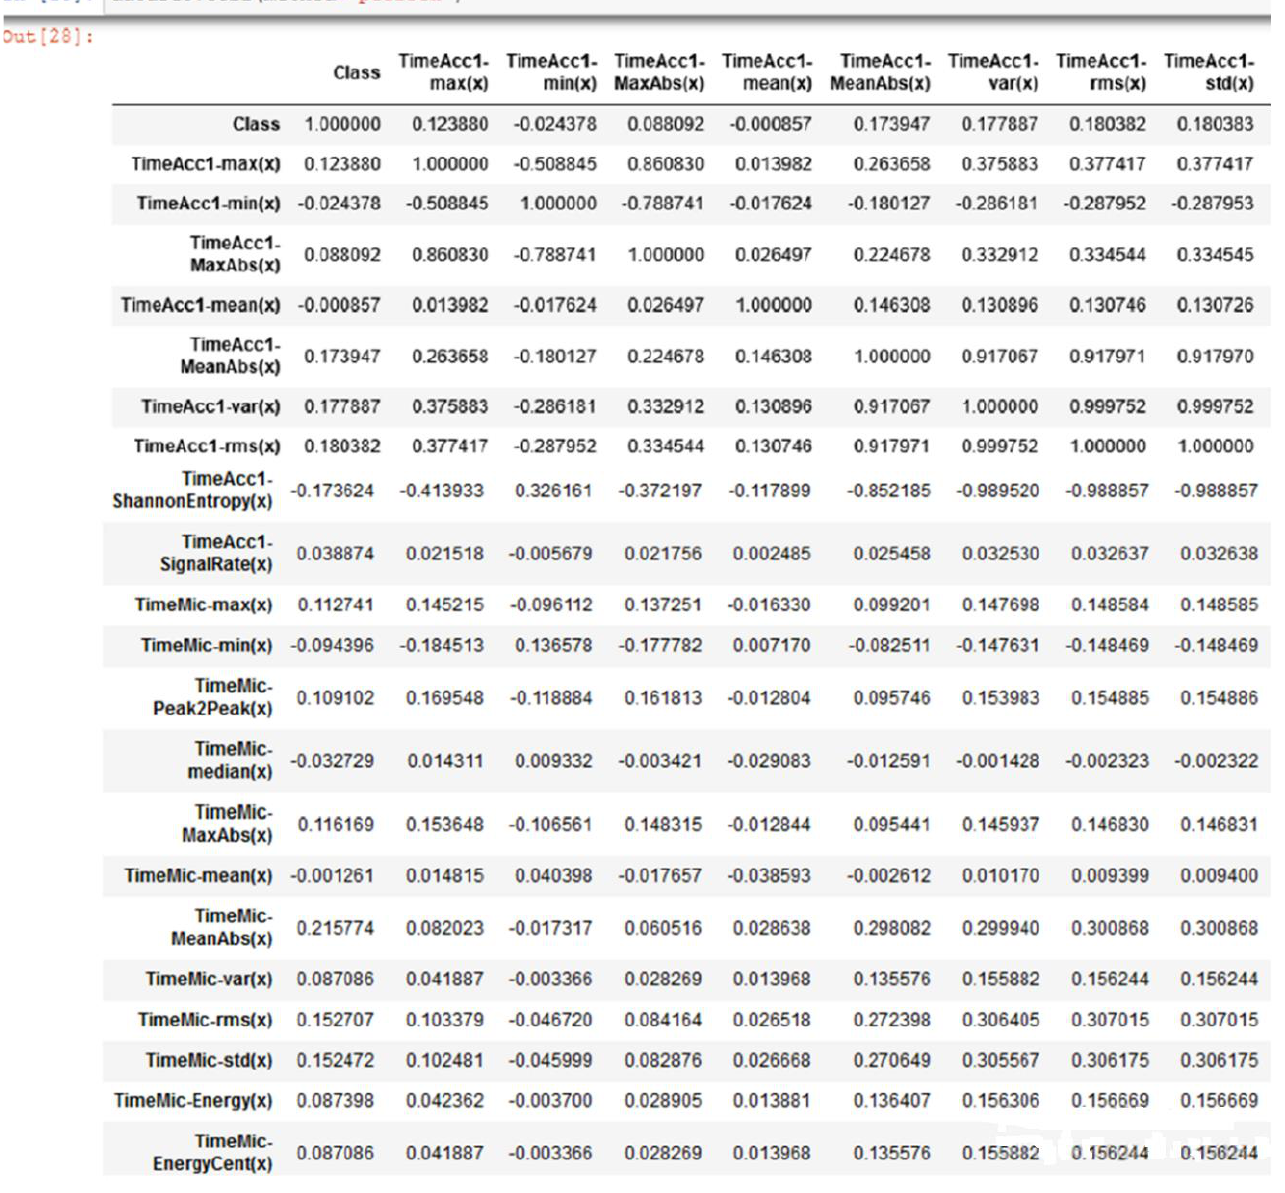
Figure 4. Correlation by Pearson ’s method.